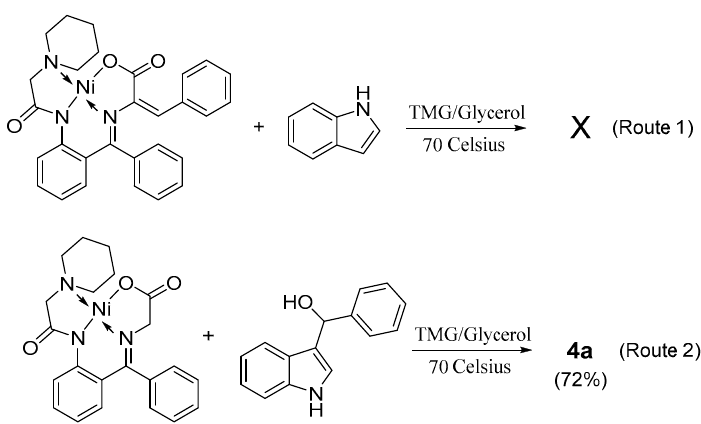
Figure 3. Plausible mechanism for the reaction.